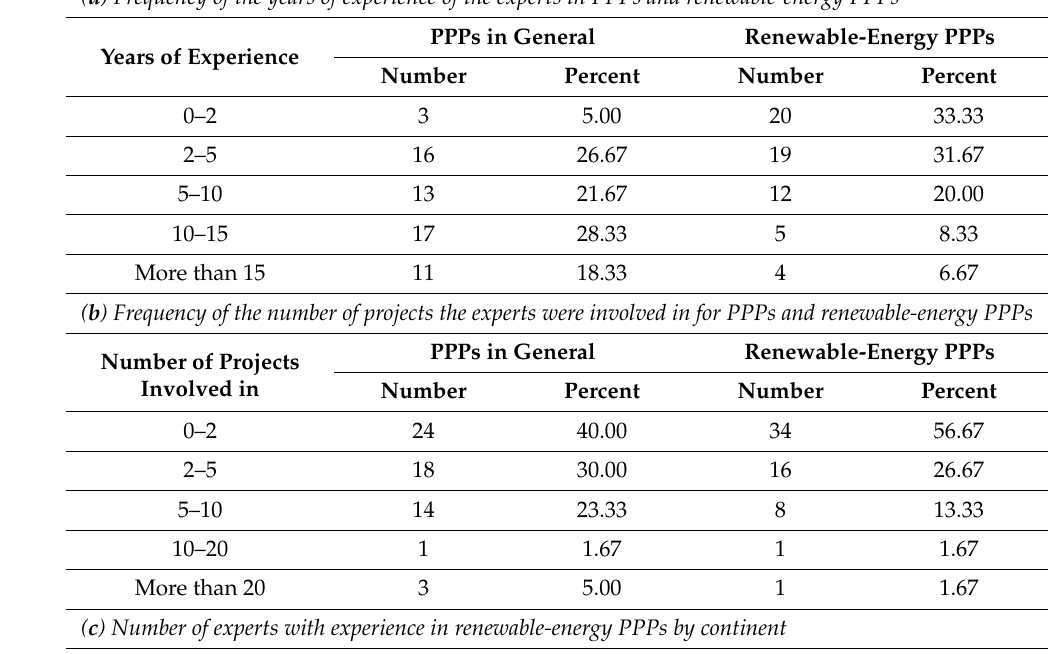
Table 1. Basic information of the